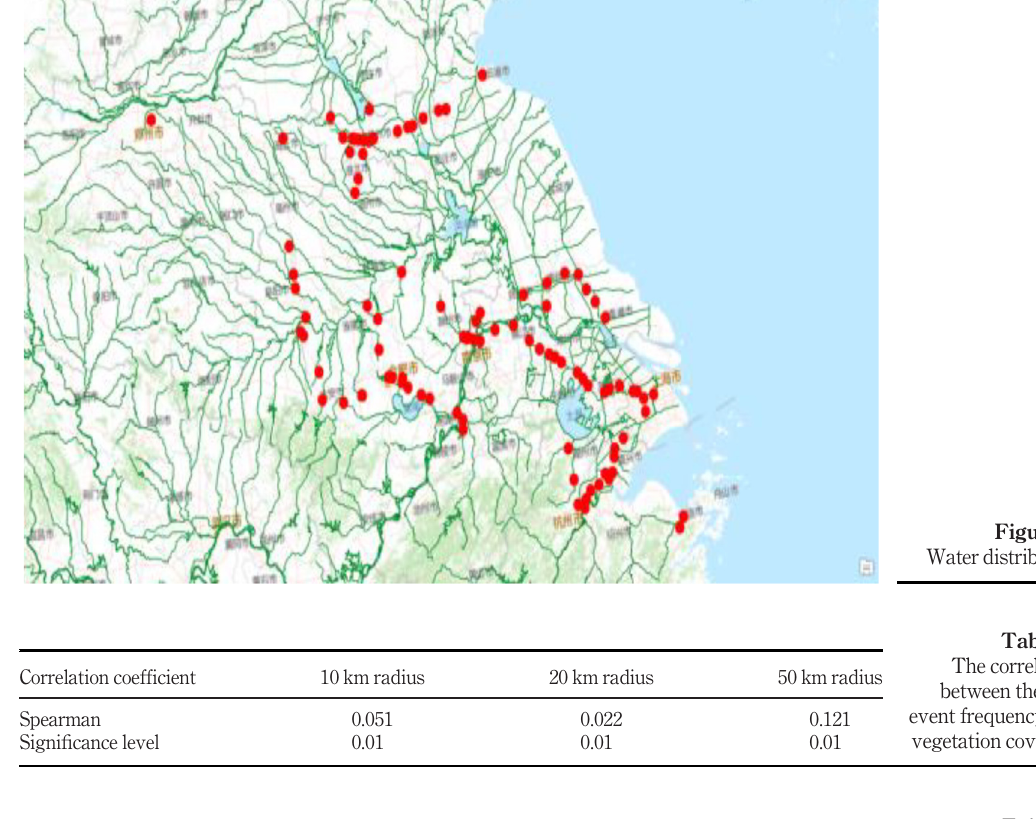
Table 2. The correlation